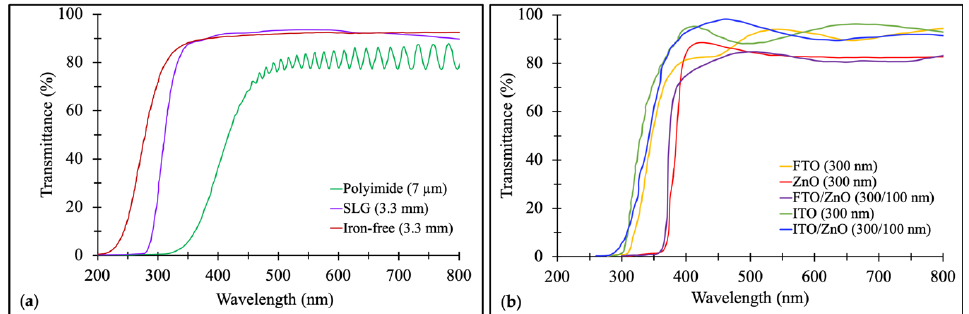
Figure 7. transmittance spectra of: ( a ) commonly used substrates such as soda-lime glass (SLG) and polyimide; ( b ) SLG (3.3 mm thick) covered with only ITO or FTO and SLG covered with ITO or FTO coupled with ZnO as a high-resistivity transparent (HRT) layer.